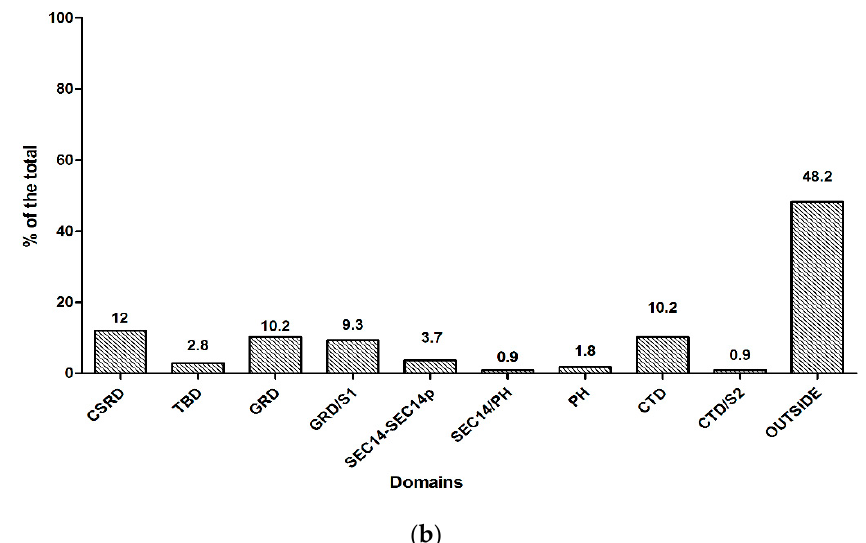
Figure 1. ( a ) Distribution of the NF1 variants by exons. ( b ) Distribution of the variants in neurofibromin domains. CSRD: cysteine–serine-rich domain; TBD: tubulin-binding domain; GRD: GTPase-activating protein-related domain; S1: syndecan binding domain 1; PH: pleckstrin homology domain; CTD: carboxy-terminal domain; S2: syndecan binding domain 2; SEC14/ SEC14p: Sec14-like lipid binding module.